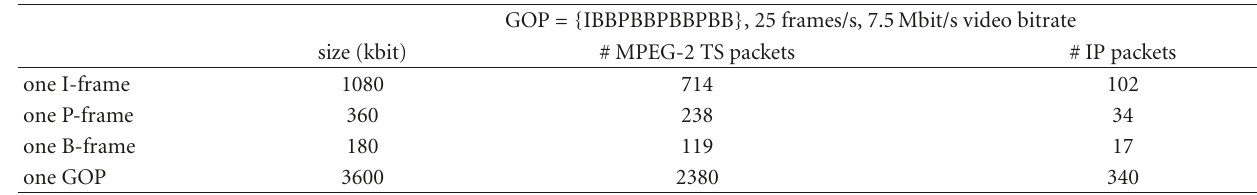
Table 1: Average sizes of I-frame, P-frame, B-frame, and GOP.